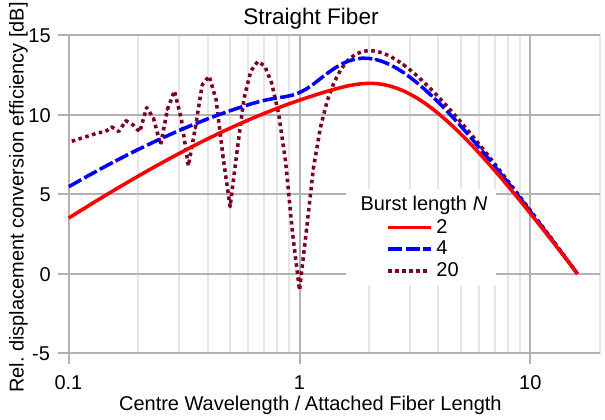
Figure 11. Normalized energy conversion of various sine-burst pulses by a straight fiber segment as a function of λ M / D . The wave strain magnitude is kept constant.